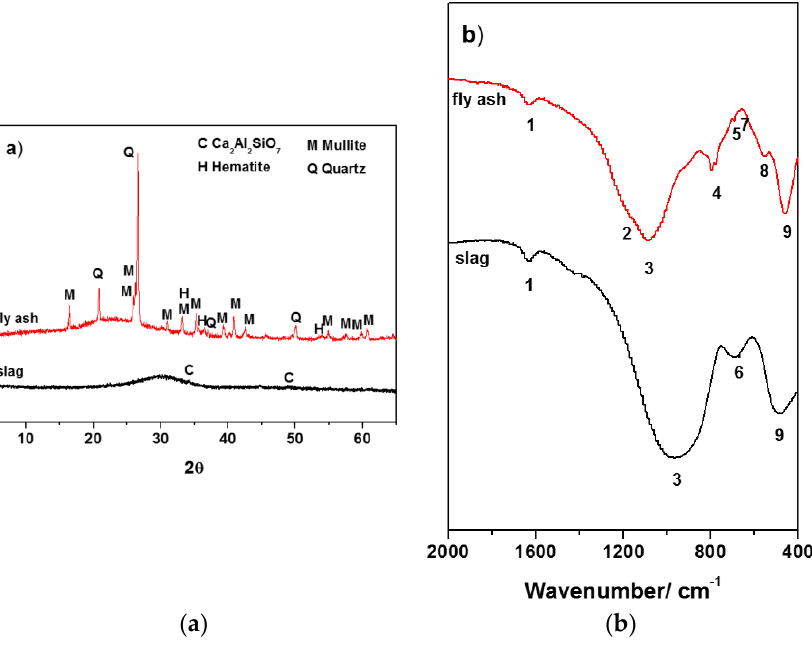
Figure 1. ( a ) XRD patterns; and ( b ) FTIR spectra of the starting materials.